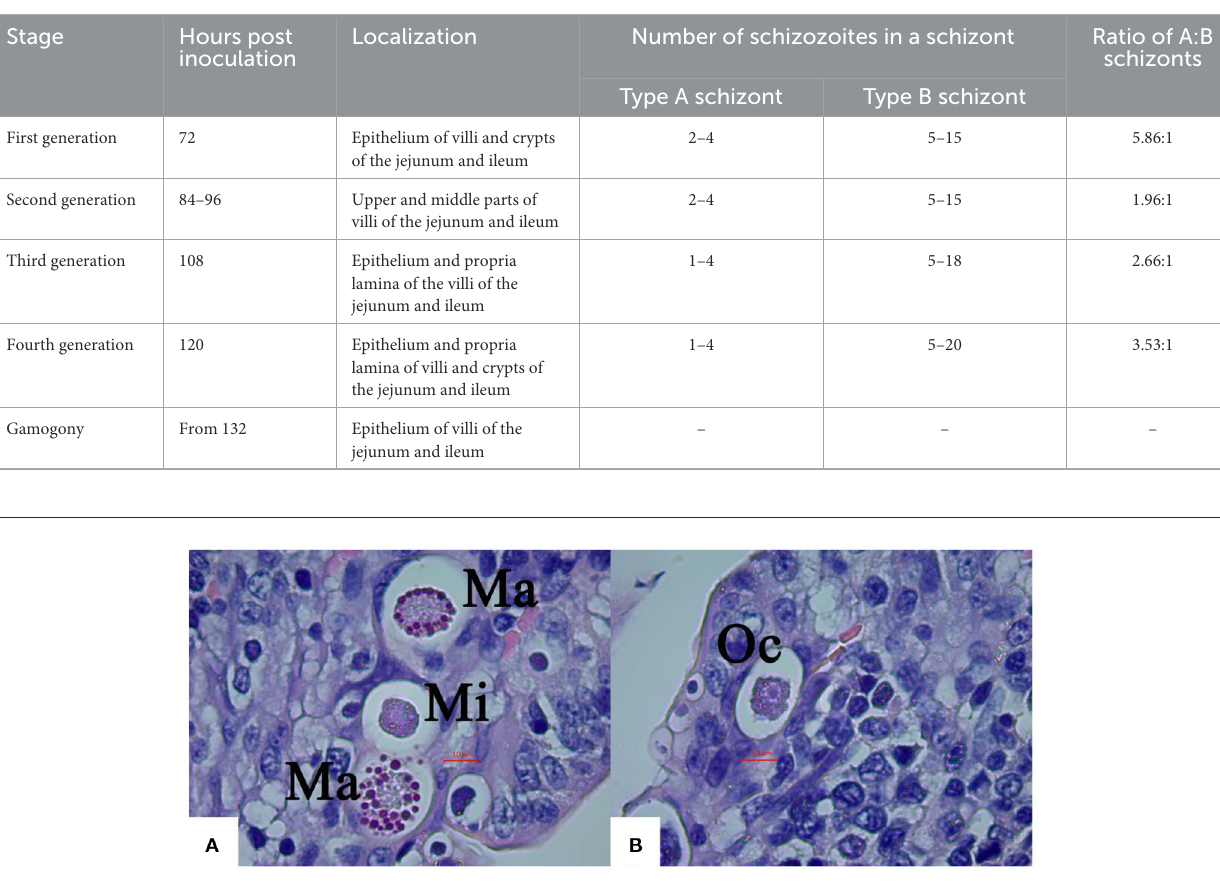
TABLE 3 A survey of the endogenous development of Eimeria kongi .